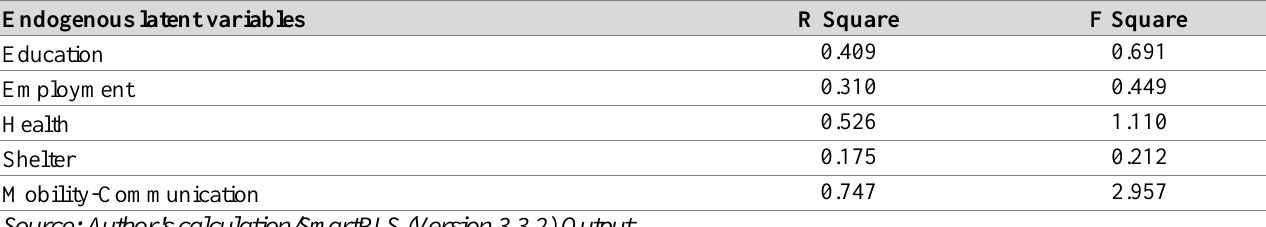
Coefficients of determination and effect